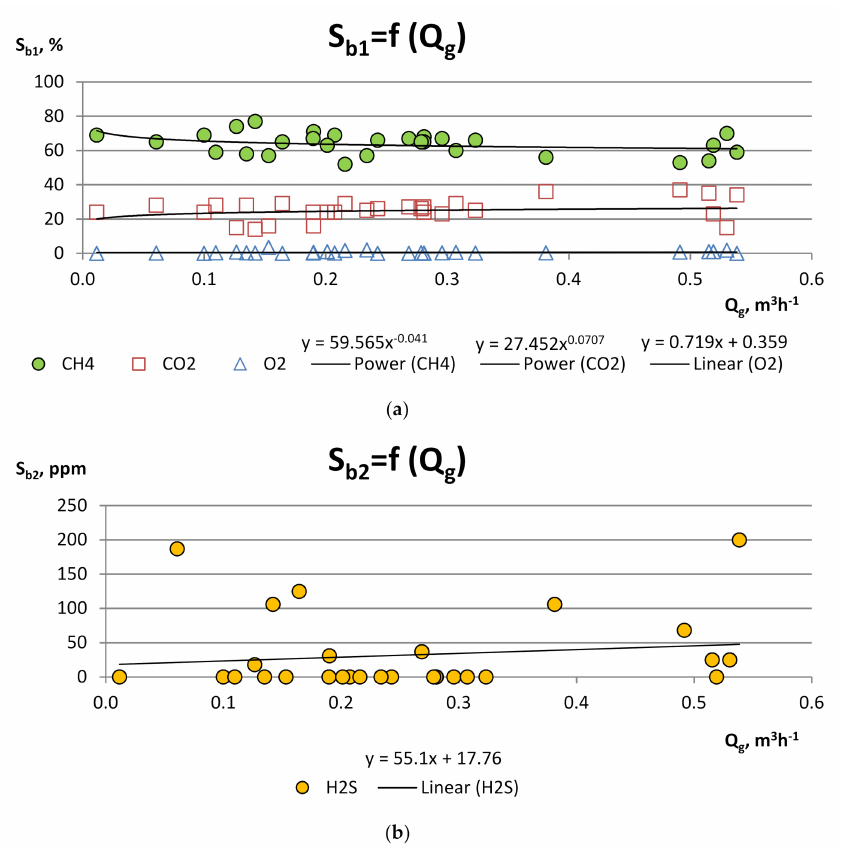
Figure 11. Composition of agricultural biogas produced from a polydisperse substrate (pig slurry)